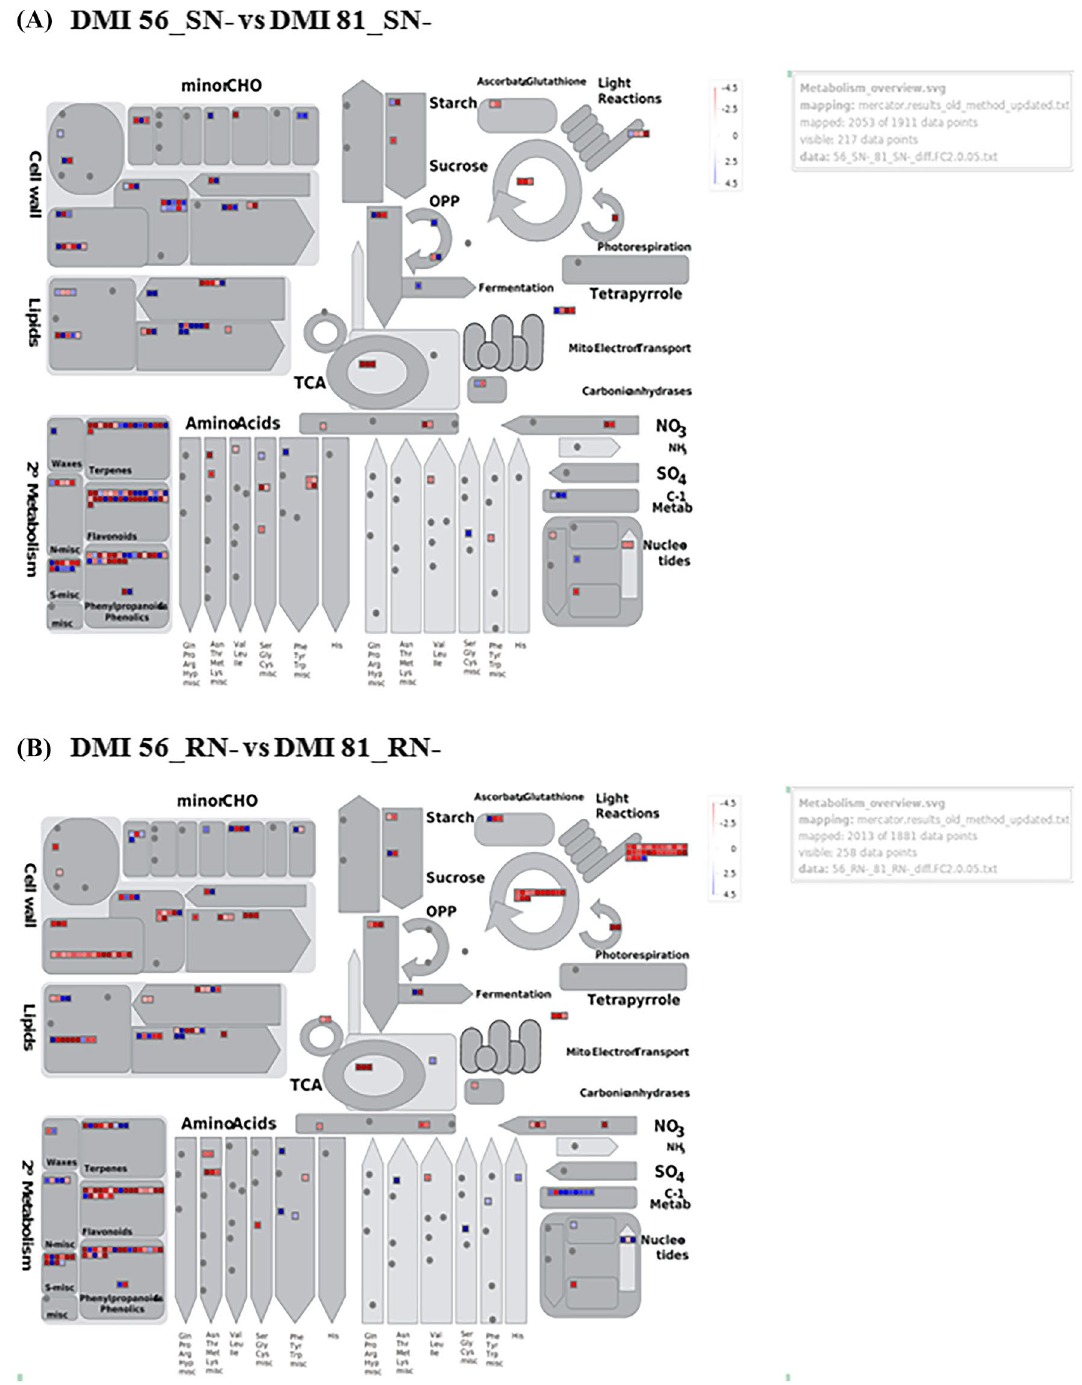
Figure 4. MapMan-based visualization of the DEGs in DMI 81 as compared to DMI 56 under low-nitrogen stress ( A ) leaf ( B ) root. Small blue and red colour squares represent up-and down-regulated genes, respectively at the amplitude of 4.5 to − 4.5